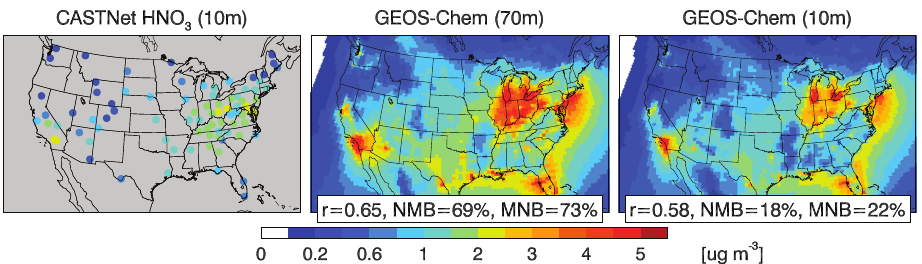
Fig. 4. Annual mean HNO 3 concentrations in near-surface air in 2006. Measurements from the CASTNet sites at 10-m altitude (left panel) are compared to GEOS-Chem model values in the lowest model layer (70m; middle panel). The right panel shows GEOS-Chem HNO 3 concentrations at 10 m inferred from aerodynamic resistances to dry deposition (see text). The correlation coefficients ( r) , normalized mean biases (NMB), and mean normalized biases (MNB) are shown